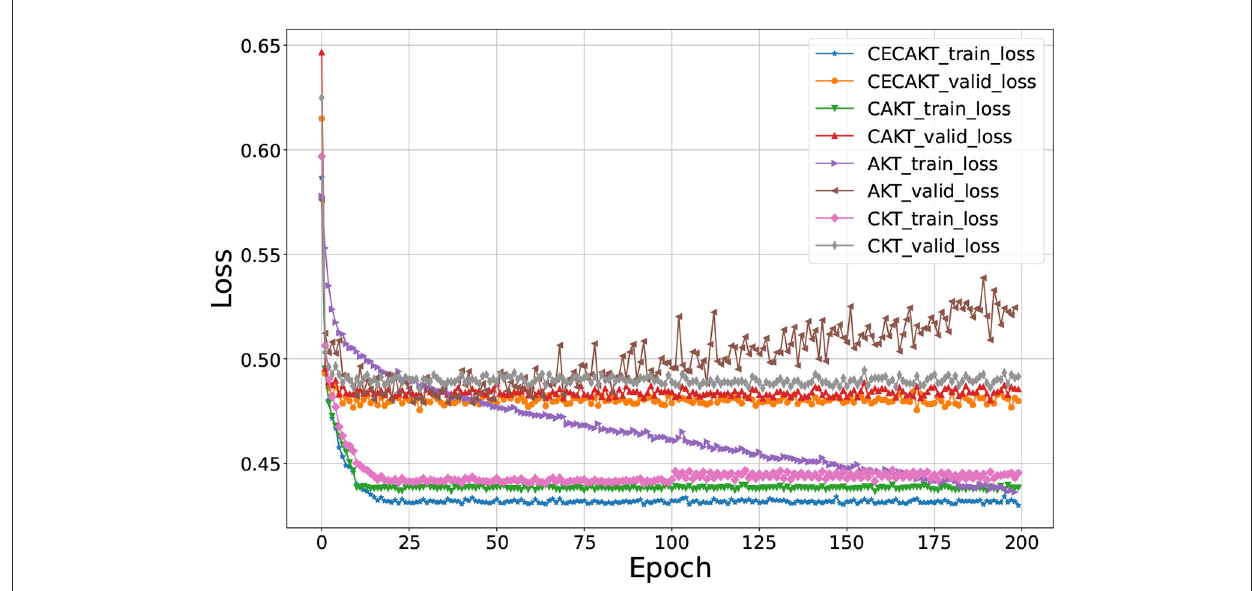
FIGURE5 Convergence rate. The horizontal axis represents the number of epochs, and the vertical axis represents the loss values.